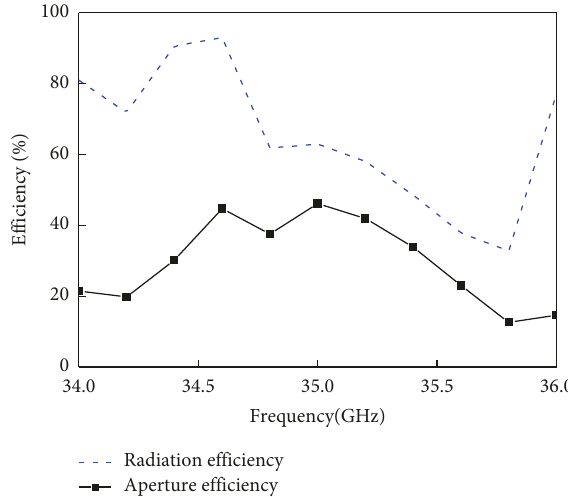
Figure 13: Measured radiation efficiency and aperture efficiency.